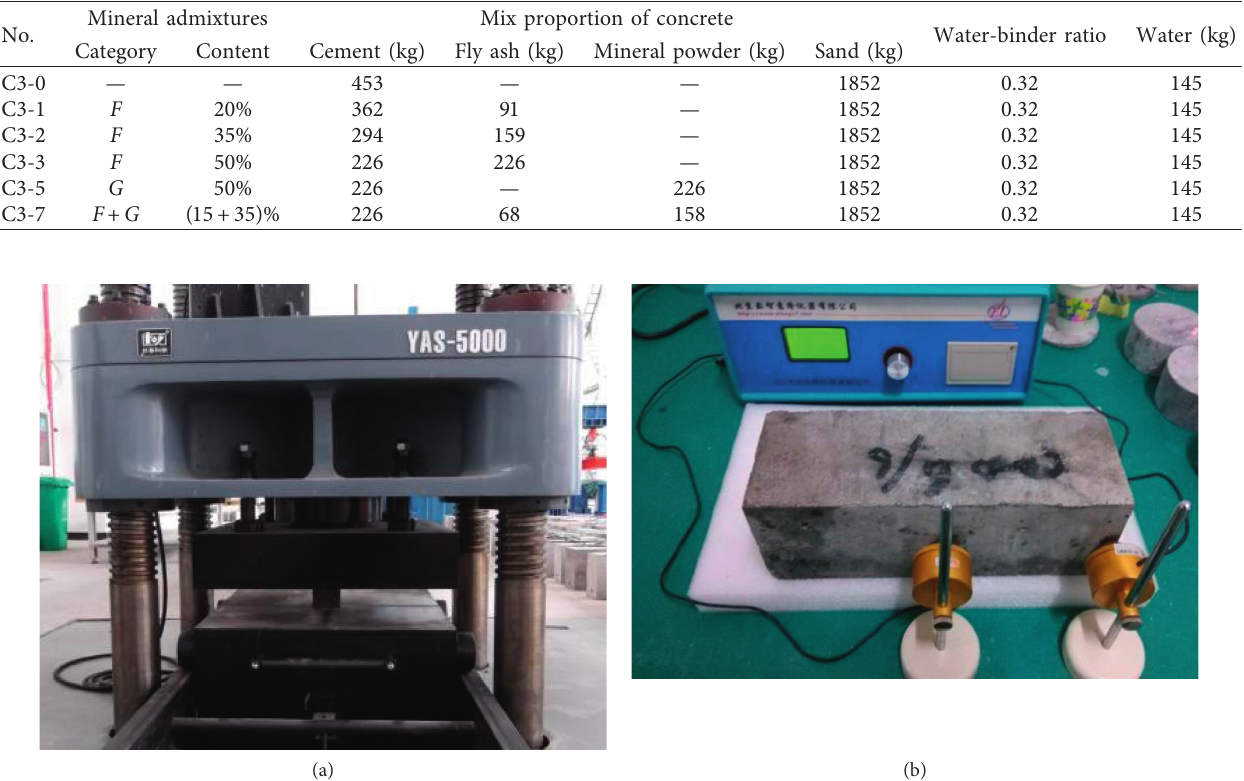
Table 1: The content of different admixture concrete